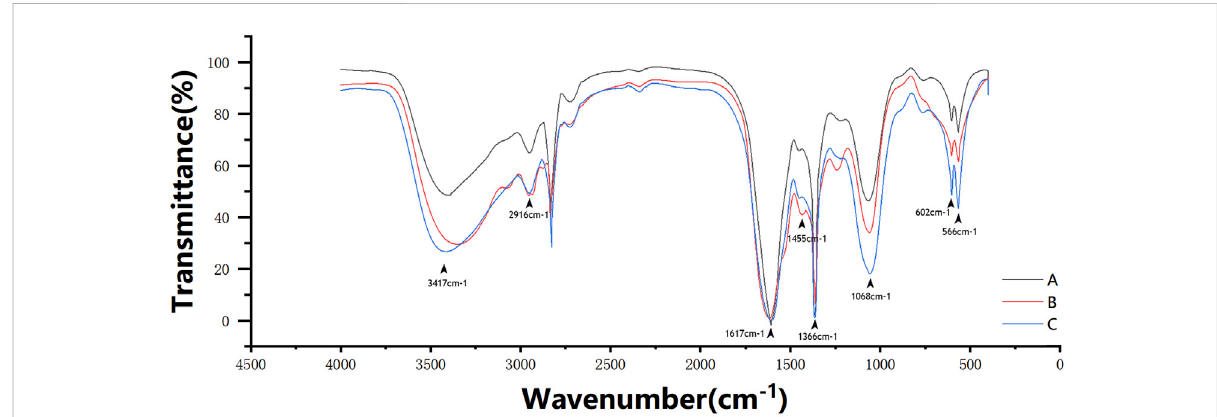
FIGURE 5 FTIR spectroscopy spectral pro fi le of the three scaffold groups. The absorption peak at ~3,417 cm − 1 belongs to the – OH and – NH vibration absorptions. ~2,916 cm − 1 belongs to – CH, ~1,366 cm − 1 belongs to – CH 2 , and ~1,068 cm − 1 belongs to – C – O – C – . The amide I bands at ~1,617 cm − 1 overlapswiththeamideIIbandsat~1,557 cm − 1 toformabroadpeak.Thepeakat~1,455 cm − 1 referstotheC – Nstretch.Thepeaksat~602 cm − 1 and ~566 cm − 1 refer to PO 4 3+ from nano-HA.